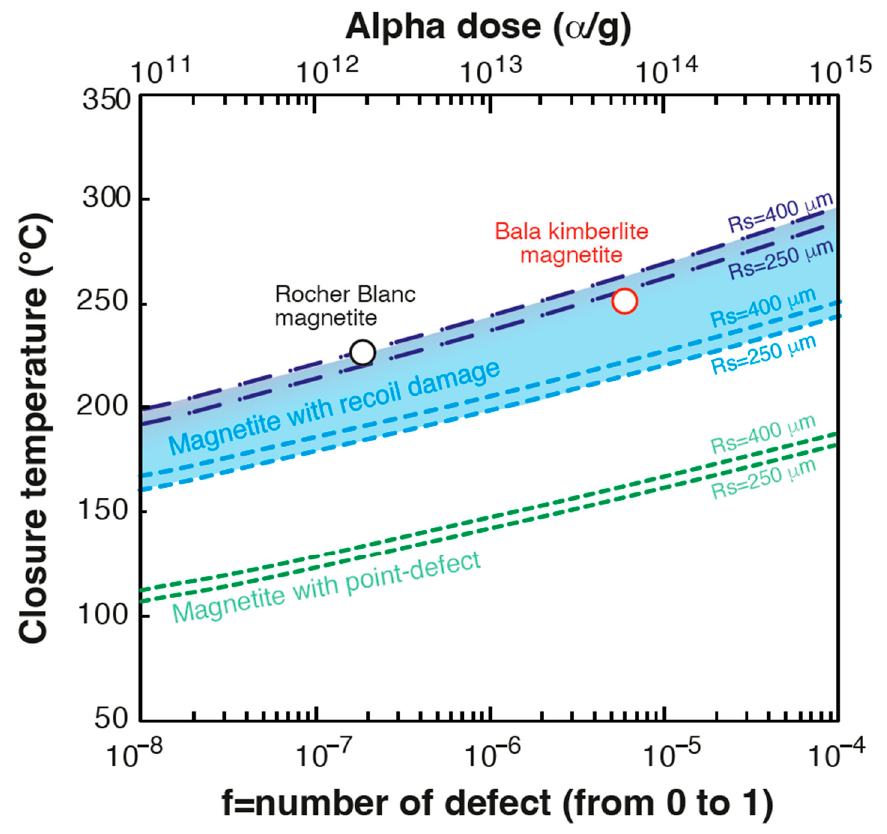
Figure 5. Evolution of closure temperature (T c ) as a function of defect fraction (from 10 − 8 to 10 − 4 ) and alpha dose (10 11 to 10 15 alpha/g), for a magnetite with point defects and with recoil damage (E a =2.1 eV (light blue dashed lines) and 2.28 eV (dark blue dashed lines), with a g factor of 0.023). Calculations have been done for magnetite crystals of 250 and 400 μ m size radius. Data for Bala kimberlite magnetite [17] and Rocher Blanc ophiolite magnetite [21] are reported.